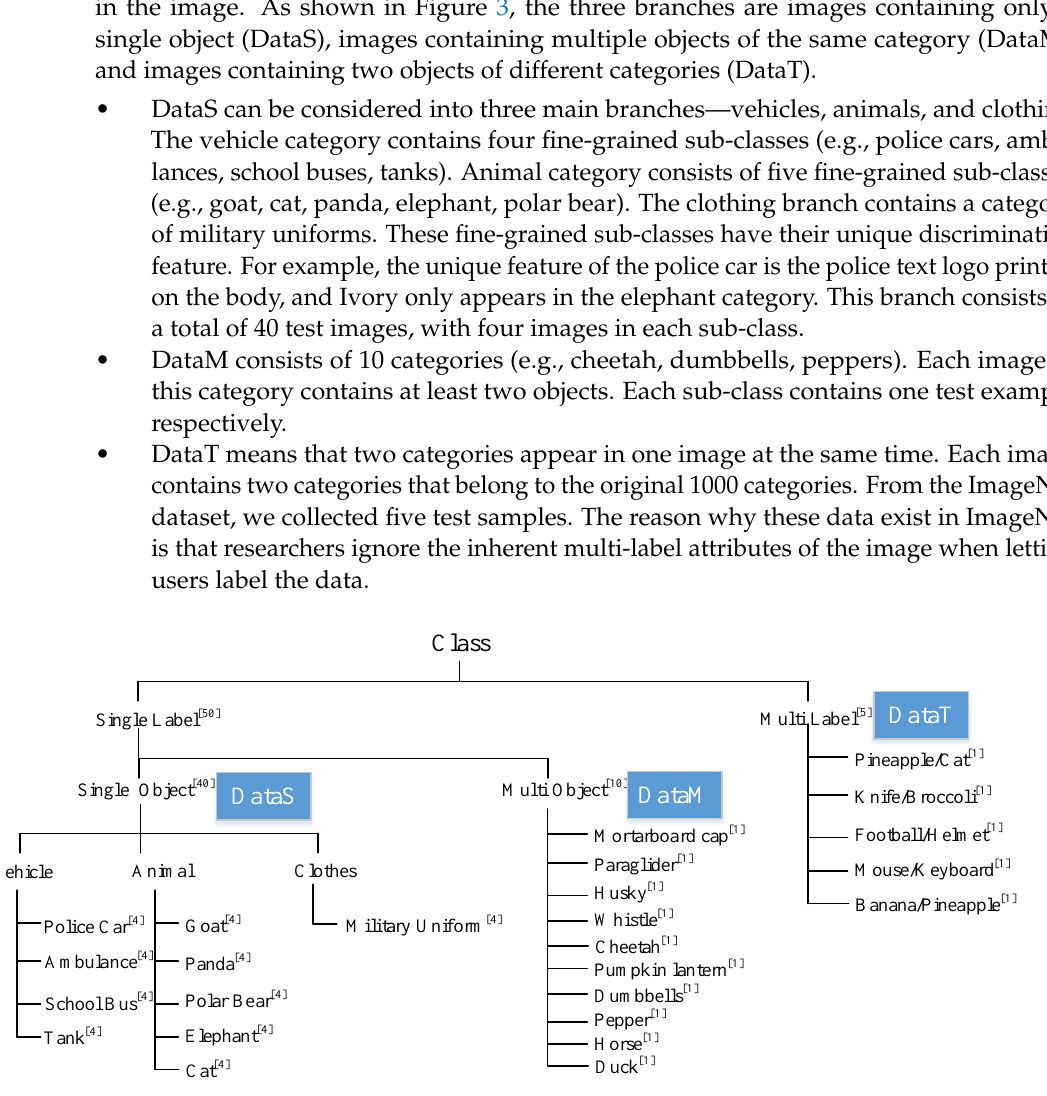
Figure 3. Schematic diagram of the hierarchical structure of the evaluation dataset. The superscript number indicates the number of each type of